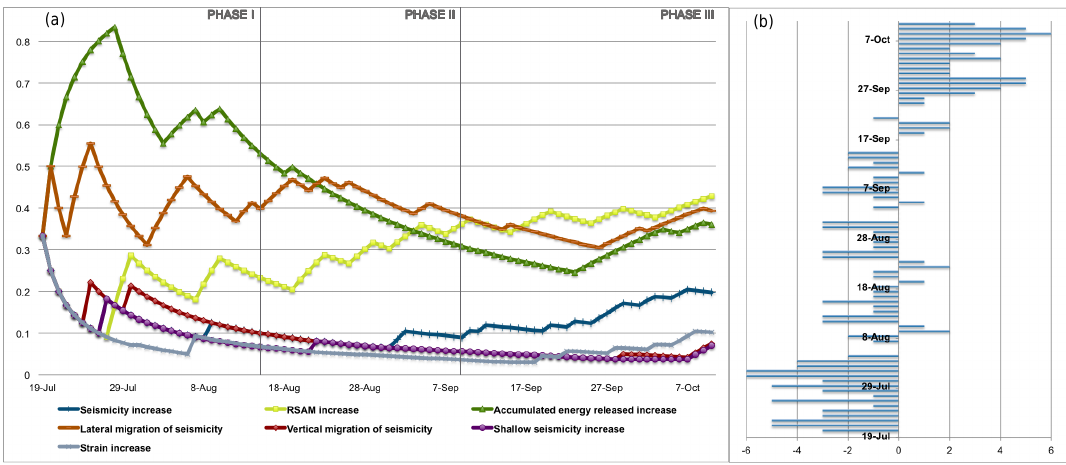
Figure 4. ST-HASSET: the evolution of the unrest indicators in three phases of 28 days. The right side of the chart shows the day-by-day tendency of variation of the unrest